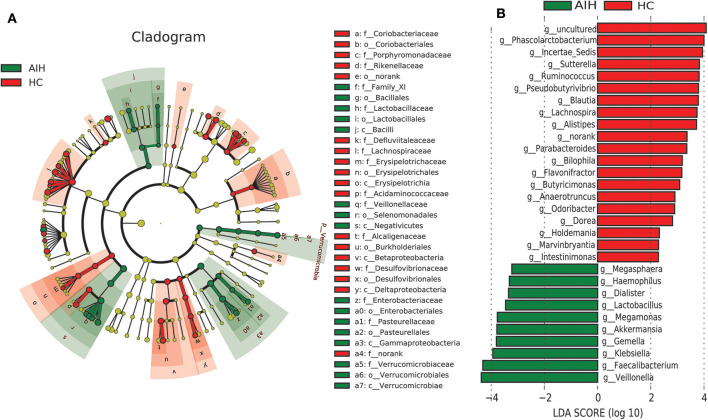
LEfSe and LDA analyses based on OTU characterizations of microbiota in AIH (N = 37) and HCs (N = 78). (A) Cladogram generated by the LEfSe method indicating phylogenetic distribution of fecal microbiomes associated with AIH patients and HCs. Each filled circle represents one phylotype. Phylum and class are indicated by name on the cladogram. Order, family, and genus are listed on the right panel. Circle size is proportional to phylotype abundance. By default, it is arranged outward from phylum to genus. Red circles in the branches represent microbial communities playing pivotal roles in AIH. Green circles represent microbial groups playing important roles in HC. Yellow circles represent microbial groups of little significance in either group. Default LDA > 2 and P < 0.05 indicate different species and higher abundance in one group than the other. (B) Histogram of LDA scores calculated for selected taxa showing significant difference in microbe type and abundance between AIH (green) and HCs (red). LDA score on log10 scale indicated at bottom. Significance of the microbial marker increases with LDA score. AIH, autoimmune hepatitis; HCs, healthy controls; OTUs, operational taxonomic units; LEfSe, linear discriminant analysis effect size; LDA, linear discriminant analysis.